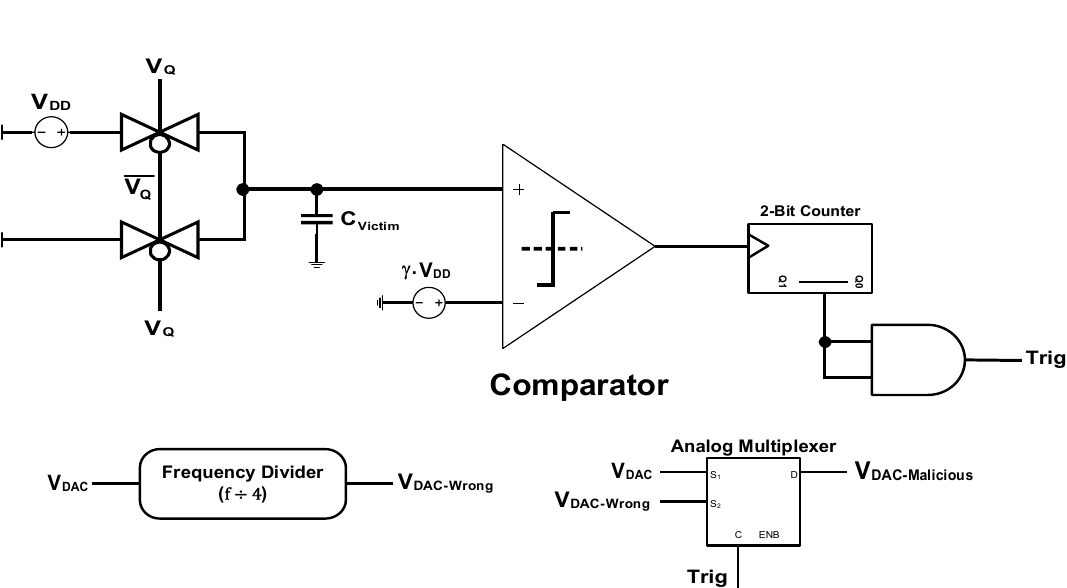
Figure 7. Attack 4: The capacitor-triggered hardware Trojan circuit for the output signal